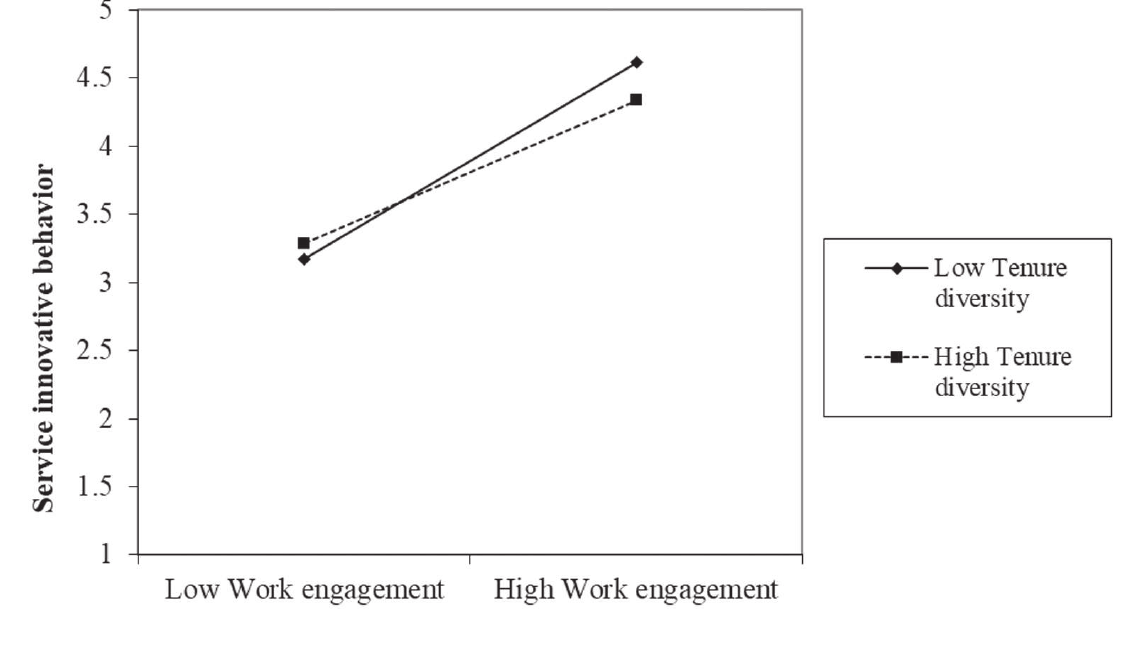
Figure 1. Moderating effect of tenure